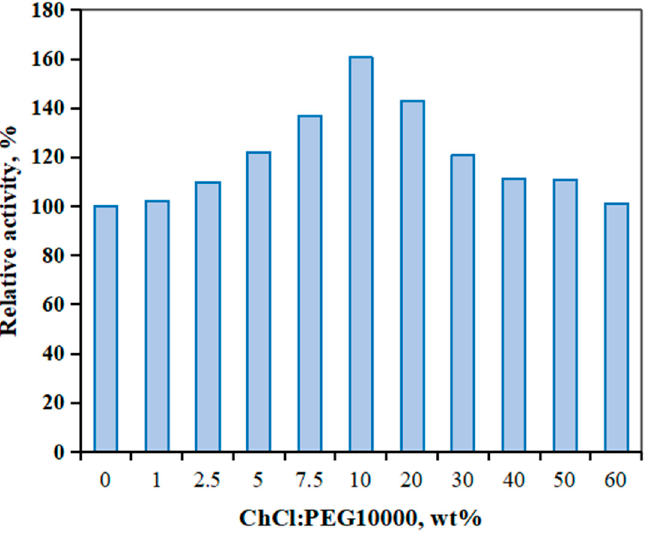
Figure 9. Effects of ChCl:PEG10000 load (0–60 wt%) on the biological reduction [NADP + (1 mmol NADP + per mol FAL, glucose (1.5 mol glucose per mol FAL), pH 7.0, 35 °C]. In the absence of ChCl:PEG10000, the bioreduction activity was defined as 100%. The FAL-reducing activity was quantified based on the bioreduction reaction rate.